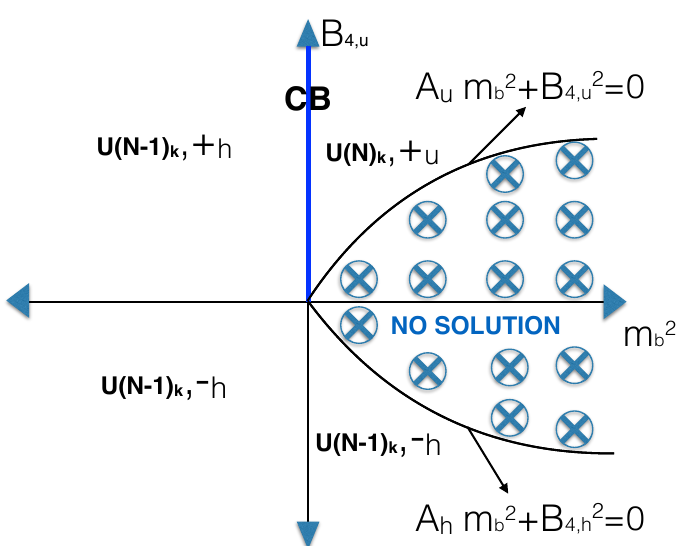
Figure 8. The phase diagram for x 6 > (cid:30) 2 . For B 4 ;u > 0 we have a second order phase transition at m 2 = 0 between + u and + h phases, while for B 4 ;u < 0 the b exists. There are no solutions for large enough values of m 2 blue crosses in the (cid:12)gure.